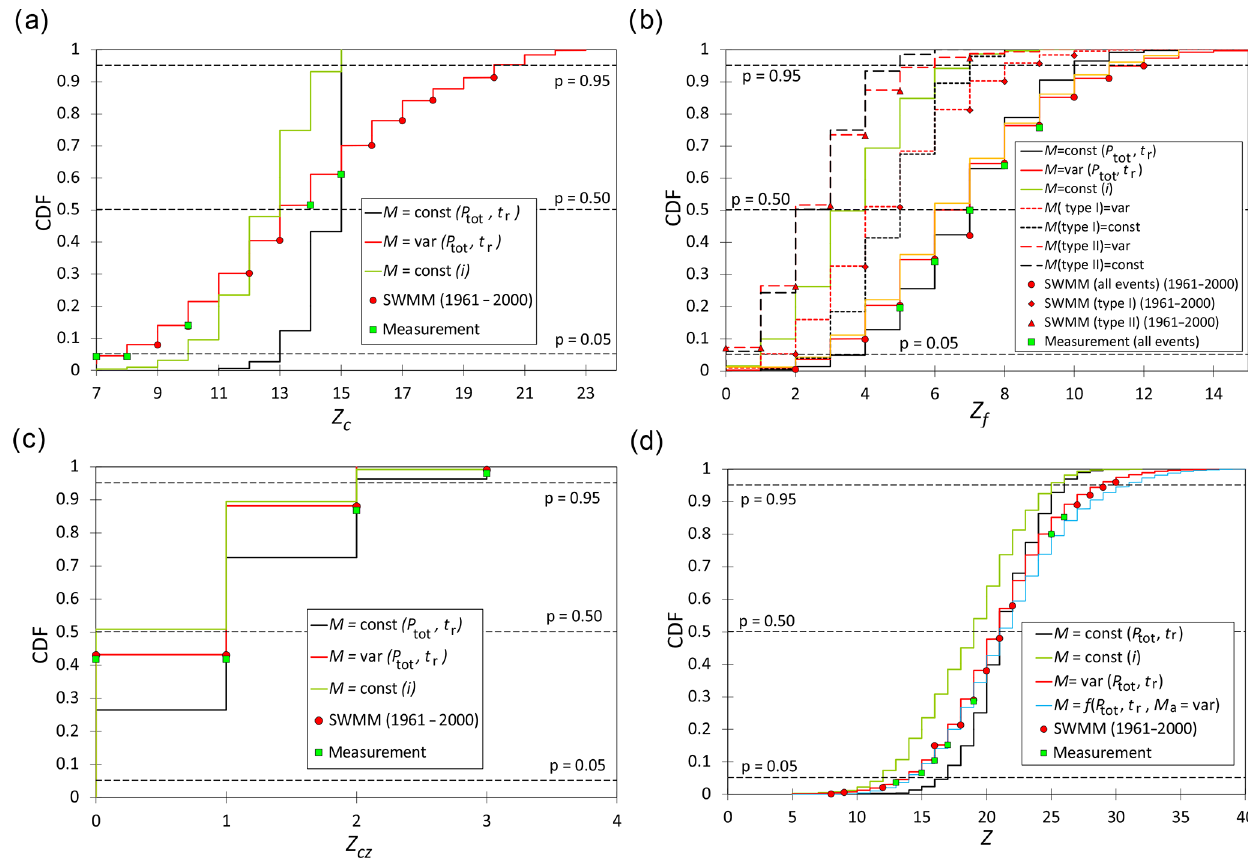
Figure 9. Distribution function (CDF) showing the annual number of storm overflow events ( Z ) caused by (a) convective rainfall, (b) frontal rainfall, and (c) rainfall in the convergence zone. (d) Curve showing the probability of non-exceeding the annual number of overflows ( Z ). Explanations of the other symbols are in the